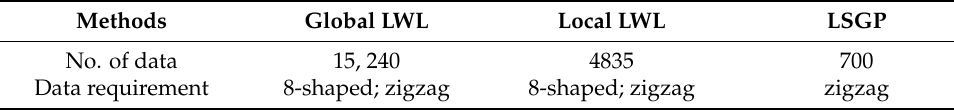
Table 3. Data requirements of different